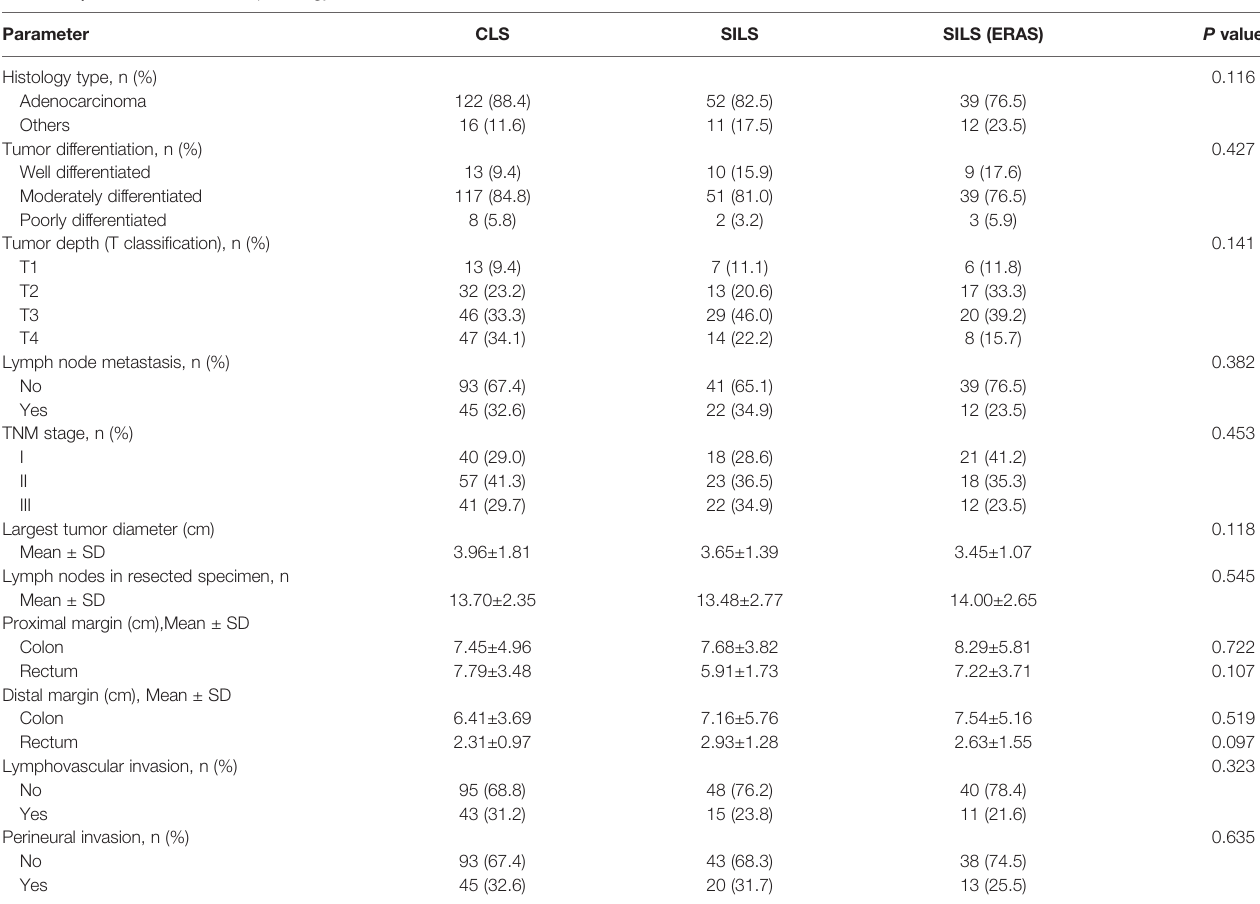
TABLE 4 | Data related to tumor